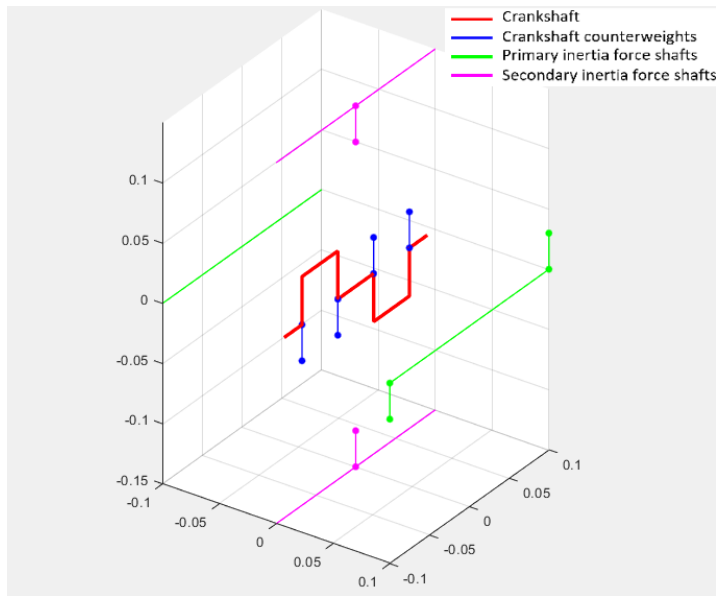
Figure 14. Geometry of crankshaft and balancing shafts for a 4 cylinder V-engine.